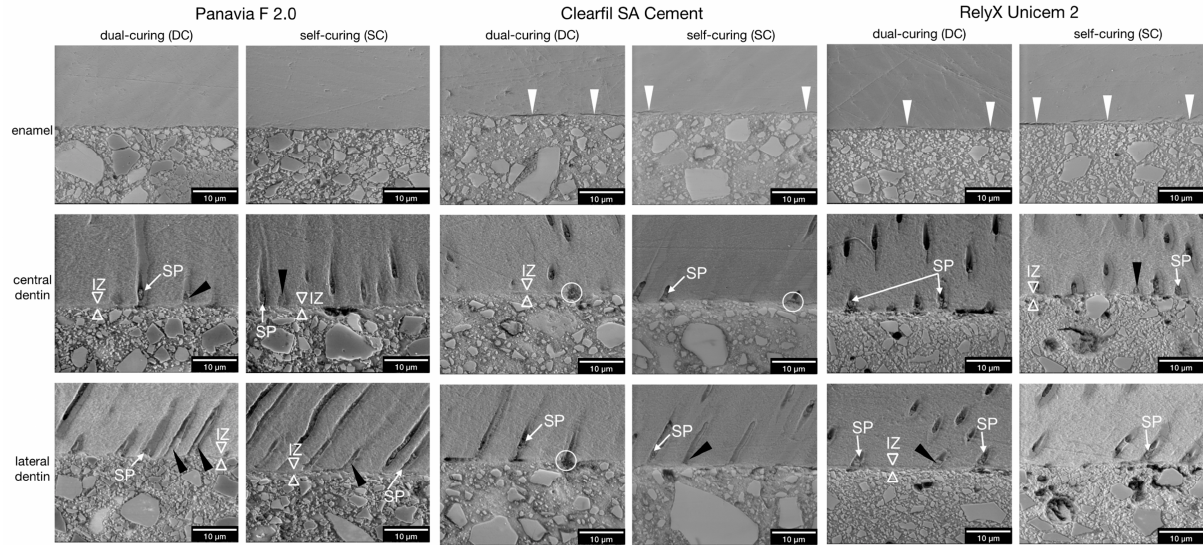
Figure 5. Adhesive interface micromorphology in polished specimens (Experiment 1) after dual-curing or self-curing (original magnification × 6000). Left panel: Marginal gaps between enamel and luting agent could not be observed in any of the PAN specimens. No deeper interaction or etching pattern could be revealed in enamel. In dentin, a distinct interdiffusion zone (IZ) was visible in half of all specimens. Smear plugs (SP) and broad tag-like structures (black arrow heads) were present inside the dentinal tubules. To demonstrate the are selection, the respective micrographs of PAN, DC, lateral dentin at × 800 and × 3000 original magnification are shown in Figure 3. Middle panel: In CSA specimens, marginal gaps (white arrow heads) are visible for DC and SC between enamel and luting agent, which were interrupted by areas with intact bond. In dentin, a thin interdiffusion zone of approximately 1 µ m (IZ) is barely visible. Typically, pores in the luting agent were located near the orifices of dentinal tubules (white circles), possibly representing water-inclusion during material setting. Smear plugs (SP, white arrows) and tag-like structures (black arrow heads) were detected. Right panel: In RXU2 specimens, marginal gaps (white arrow heads) were found for DC and SC at the interface as well as cohesive fractures within the enamel. In dentin, smear plugs (SP) and tag-like structures (black arrow heads) representing infiltration of resin-matrix with and without filler particles into dentinal tubules coexisted. Thin interdiffusion zones (IZ, hollow white arrow heads; ~1 µ m) could be